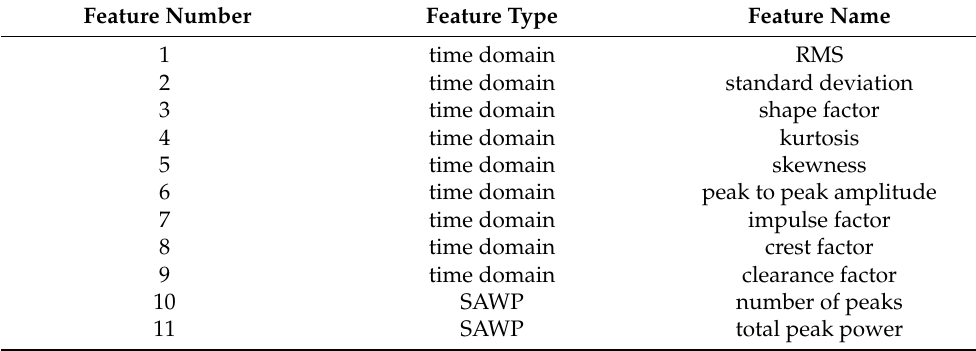
Figure 5. Magnitude scalogram of squat G in a 4 mm case. Table 2. Extracted